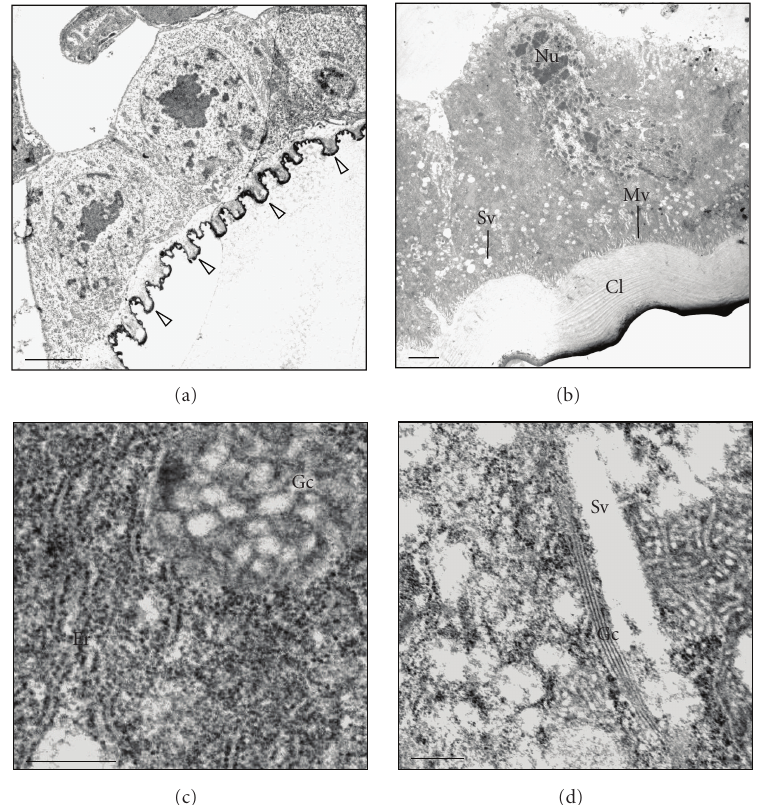
Figure 5: Transmission electron micrographs of the impair prosternal gland of Heliconius erato phyllis . (a) longitudinal section of secreting cells, showing irregular external sculpture of cuticle (open arrowheads) in a first instar; (b) longitudinal section of secreting cells of a fifth instar, with basal nucleus, several vesicles containing secretion in the cytoplasm, and abundant microvilli associated with the cuticular layers; (c) detail of the cytoplasm of cells from a fifth instar, showing well-developed rough endoplasmic reticulum and Golgi complex; (d) detail of the cytoplasm of cells from a fifth instar, showing numerous secretion vesicles. Cl: cuticular layers; Er: rough endoplasmic reticulum; Gc: Golgi complex; Nu: nucleus; Mv: microvilli; Sv: vesicle containing secretion. Scale bars: 2, 2, 0.4, 0.4 µ m,